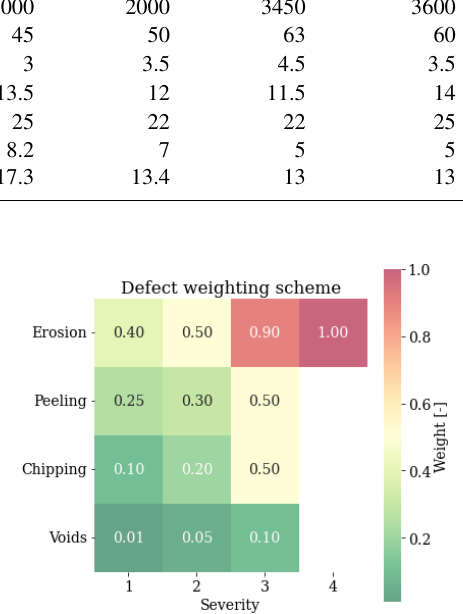
Figure 5. Scheme that is being used to assign weights to each de- fect. The weights represent the urgency of repairs, where weights close to 0 are non-structural defects and weights close to 1 are threatening the structural integrity of the